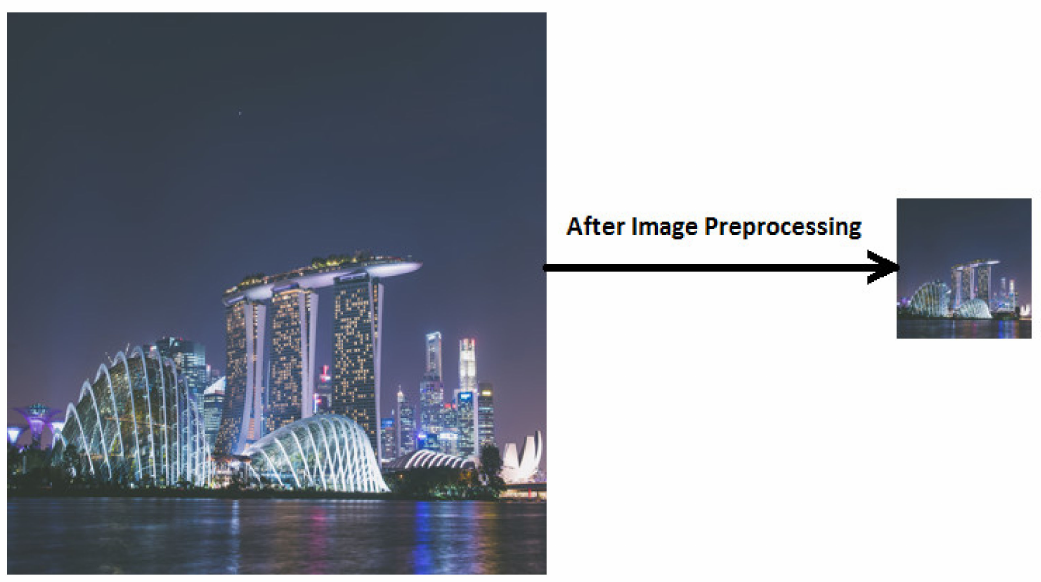
Figure 6. Images after image-degradation